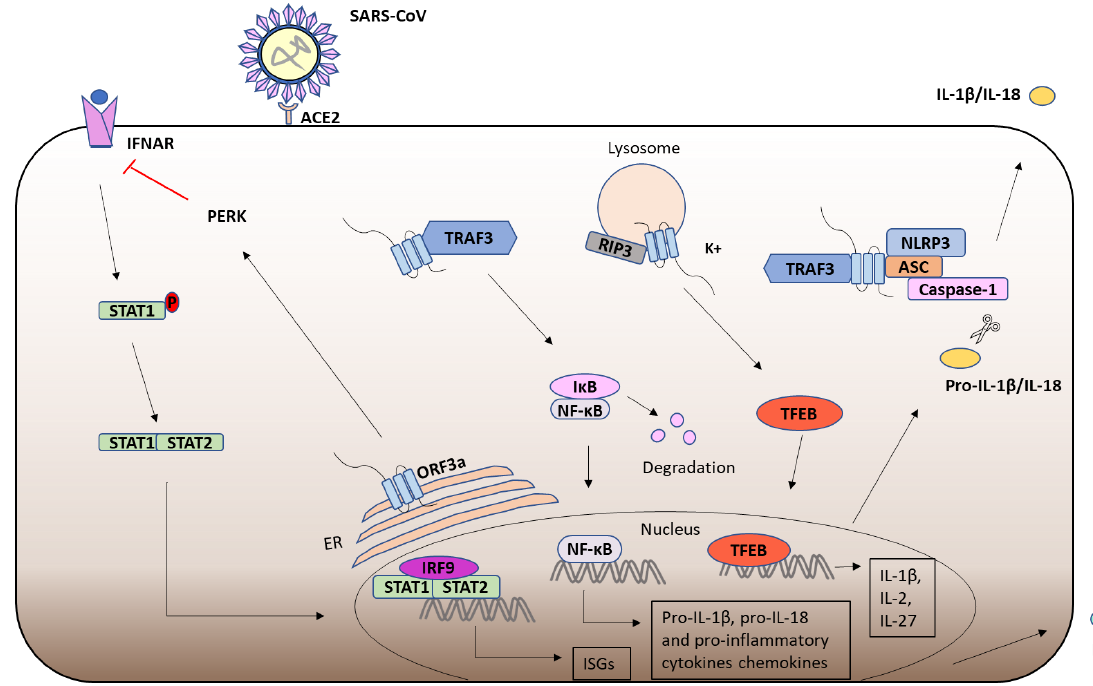
Figure 6. SARS-CoV ORF3a and the immune response. Following SARS-CoV infection of ACE2 expressing cells, ORF3a is expressed in the ER induces the PERK ER stress pathway resulting in the serine phosphorylation of IFNAR and attenuation of the IFN- α JAK/STAT signalling pathway and downstream ISG induction. ORF3a has been shown to co-localise with RIP3 in lysosomes and RIP3 has been shown to promote ORF3a oligomerisation leading to the activation of TFEB and subsequent pro-IL-1 β , IL-2 and IL-27 induction. ORF3a has also been shown to interact with TRAF3 triggering downstream NF- κ B activation and induction of pro-IL-1 β , pro-IL-18 and IL-8. ORF3a has also been shown to promote inflammasome activation, through interaction with TRAF3 and via potassium efflux, leading to cleavage of pro-IL-1 β and pro-IL-18. The release of IL-8, mature IL-1 β and IL -18 from SARS-CoV promotes inflammation, contributing to the immunopathology associated with SARS-CoV infection.